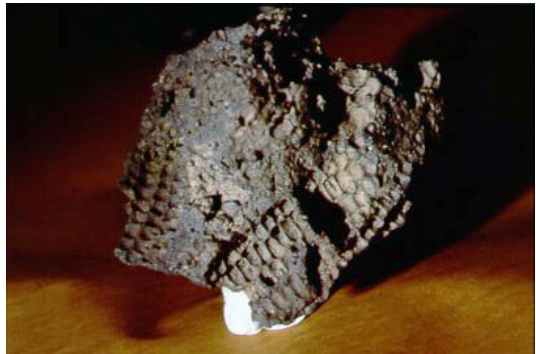
Figure 6. Corn impressions found in lava boulder during Elson’s excavations [33].